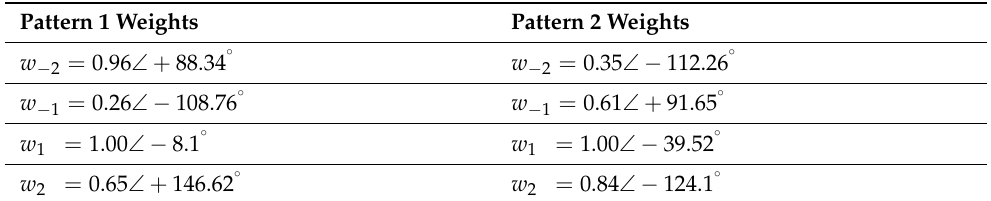
Table A2. Array weights of the conformal antenna on the wedge-shaped surface with θ b = 30 ◦ with coupling using (33).